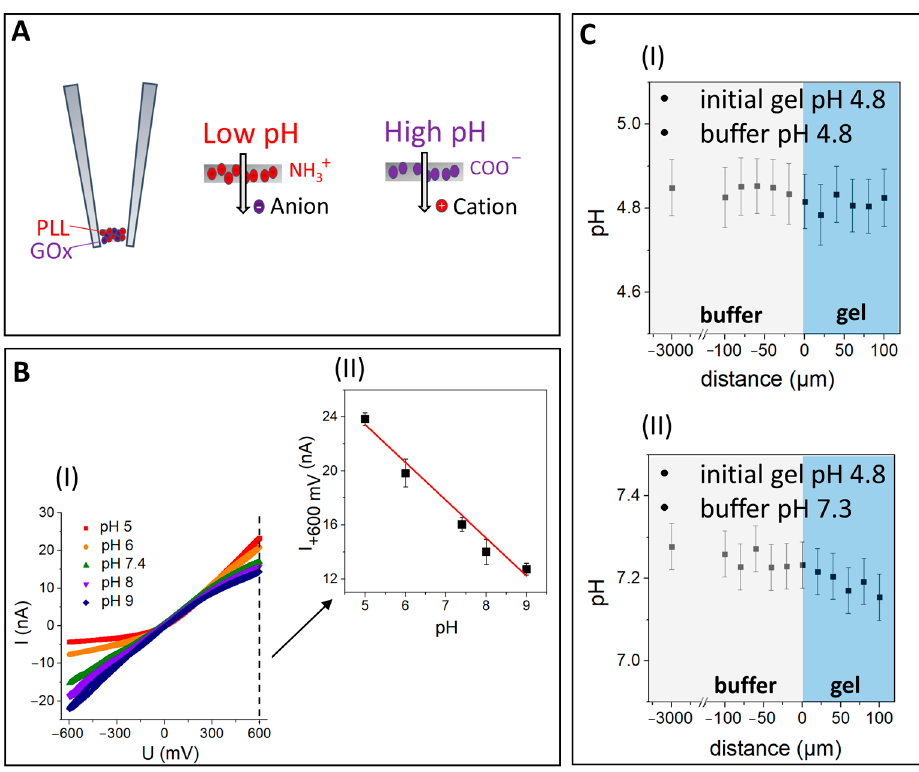
Figure 3. ( A ) The principle of operation for the sensor where the nanomembrane demonstrates preferential permeability for anions at low-pH and for cations at high-pH. ( B ( I )) Current-voltage characterization of the sensor at varying pH values. ( B ( II )) The dependence of the current on pH at 600mV. ( C ) The pH dependence of media in the buffer (gray) and inside the hydrogel (blue) at a distance from hydrogel surface for ( I ) hydrogel with initial pH value of 4.8 that was filled with buffer (pH 4.8) and ( II ) hydrogel with initial pH value of 4.8 that was filled with buffer (pH 7.3).